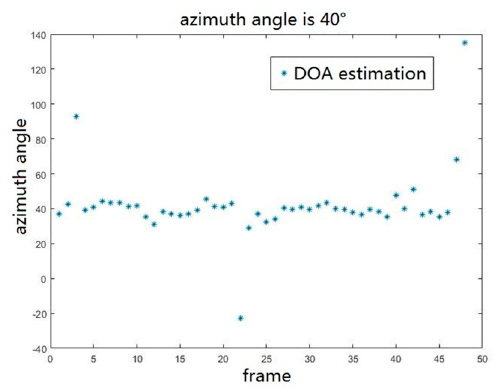
Figure 6. ( a ). the multiply frames’ DOA estimations. ( b ). the multiply frames’ DOA estimations processed by RANSAC algorithm.